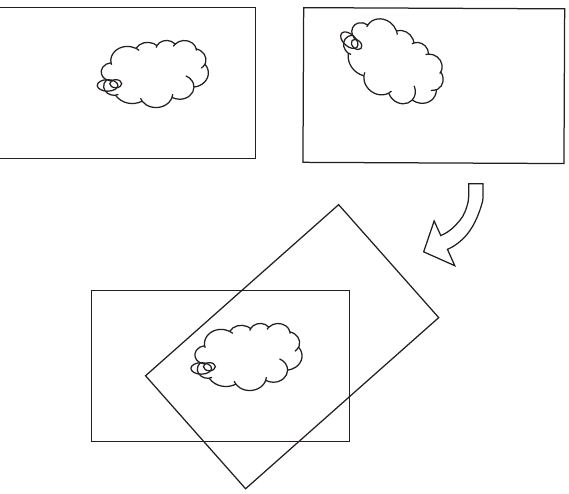
Figure 3: The image processing of rotation and